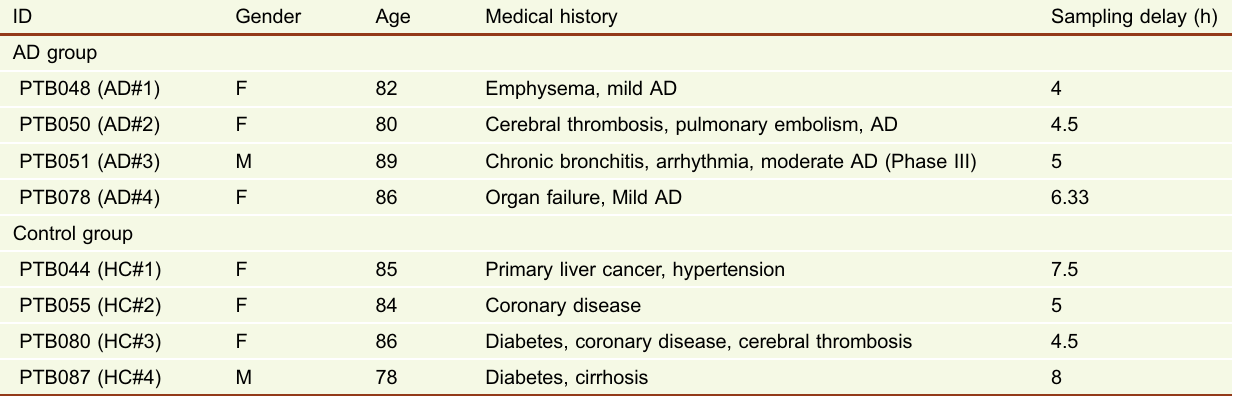
Table 1. General information of Alzheimer ’ s disease patients and healthy controls